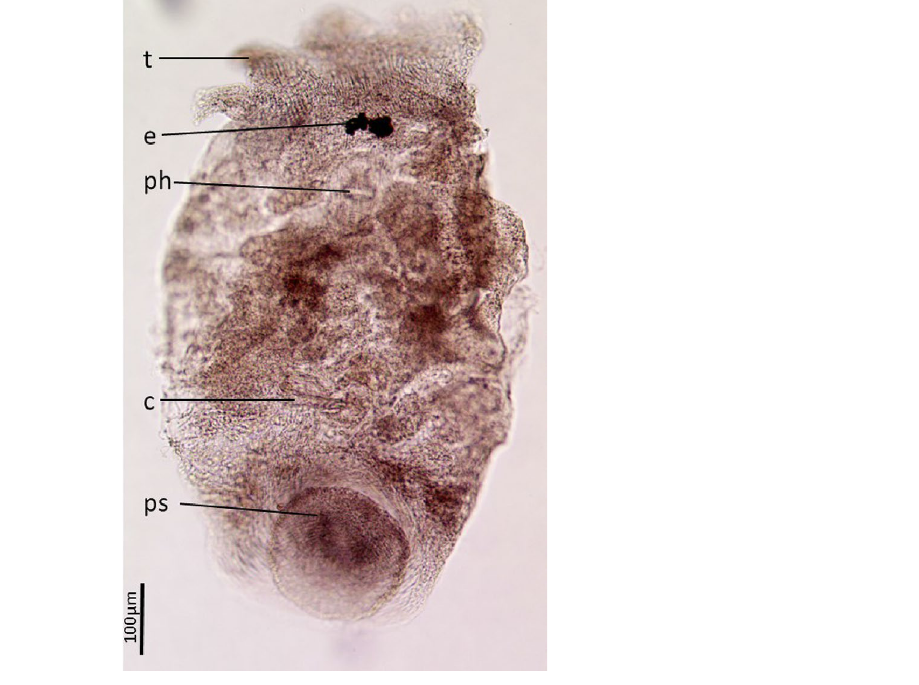
Figure 2. Microscopic image of a Temnocaphalidae found in the present study. Abbreviation includes: C cirrus, E eyespot, Ph pharynx, Ps posterior sucker, T